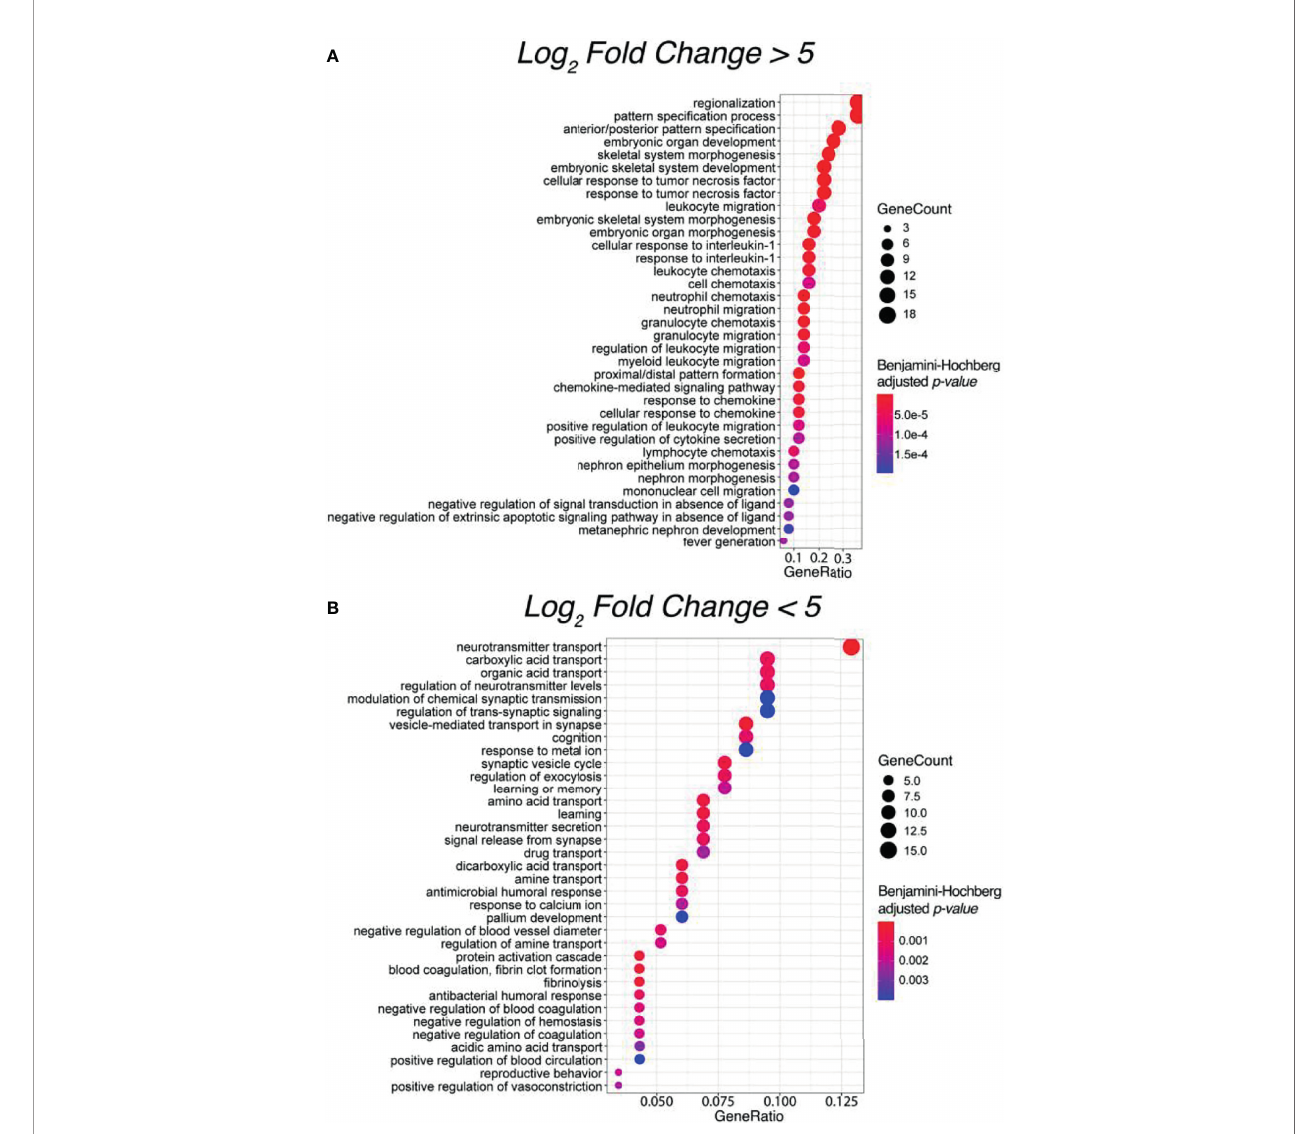
FIGURE 4 | Top 35 enriched Gene Ontology (GO) terms for signi fi cantly (A) upregulated and (B) downregulated differentially expressed genes between spinal intramedullary astrocytomas (SIAs) and healthy CNS tissues: GTEx spinal cord and ANTE normal brain